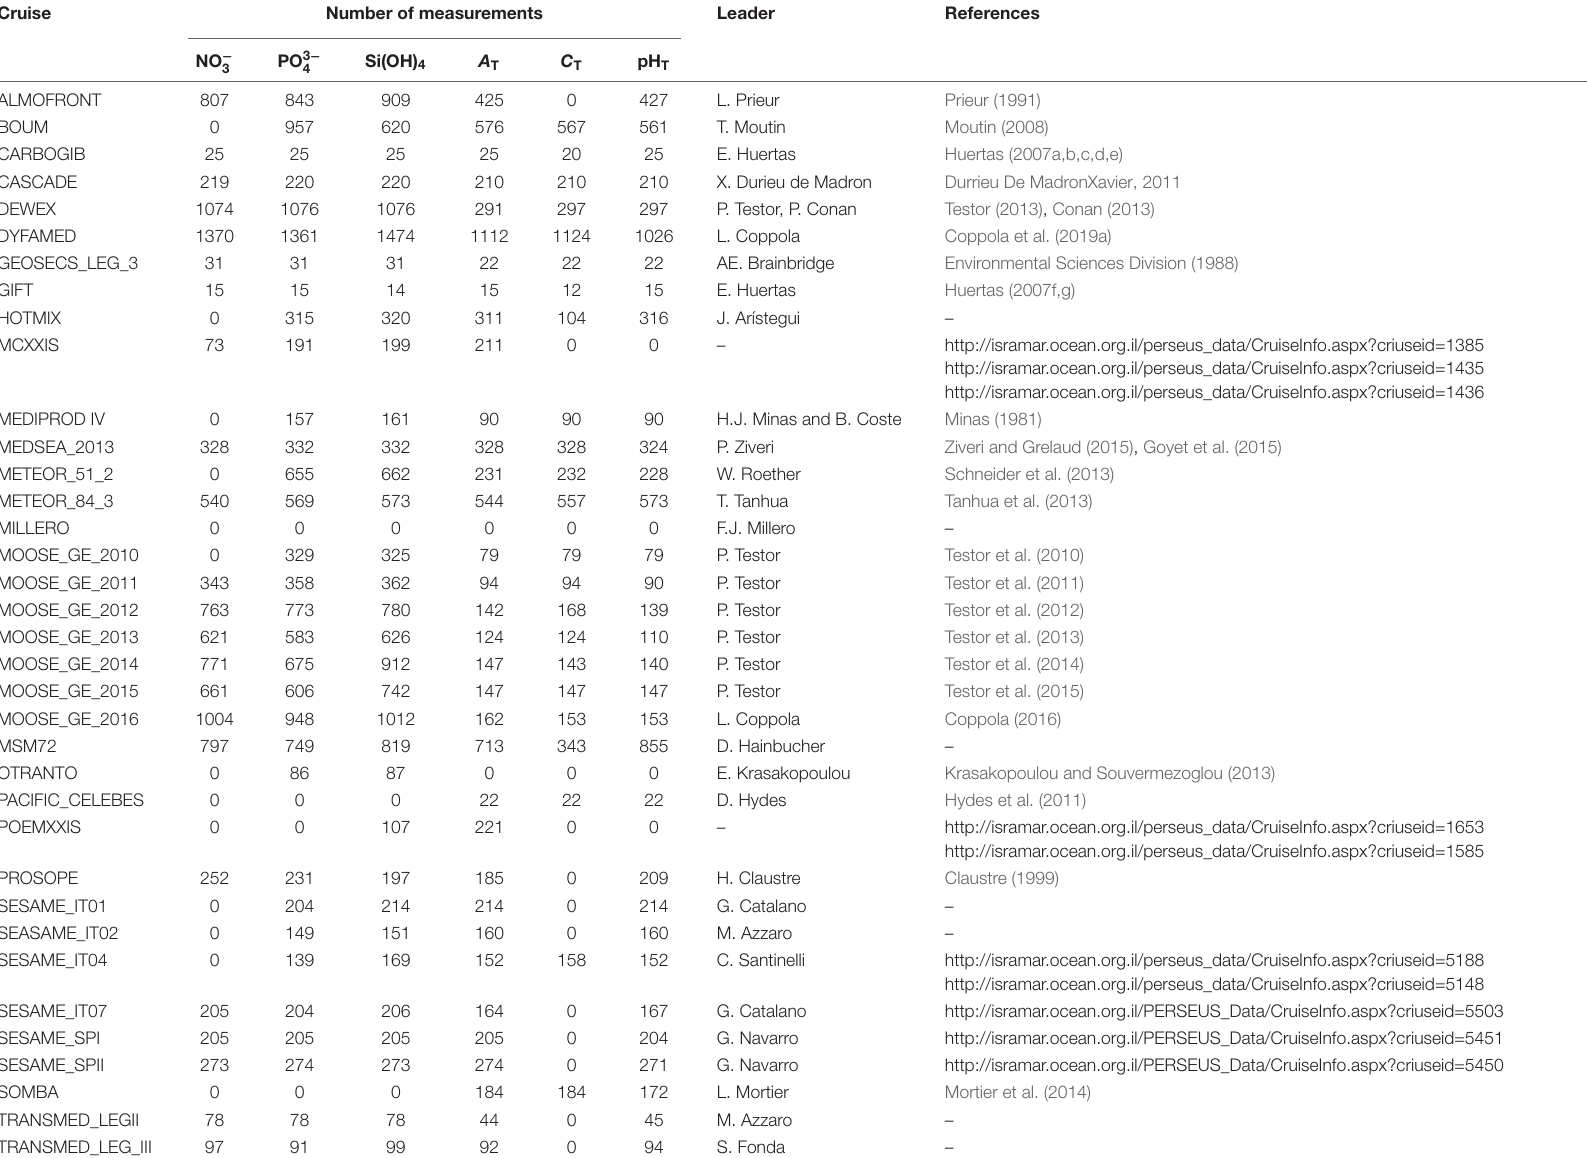
TABLE 1 | List of cruises, principal investigators, references (when available), and the number of data for each variable of interest [NO − 3 , PO 3 − 4 , Si(OH) 4 , A T , C T , pH T ] in our database. Cruise Number of